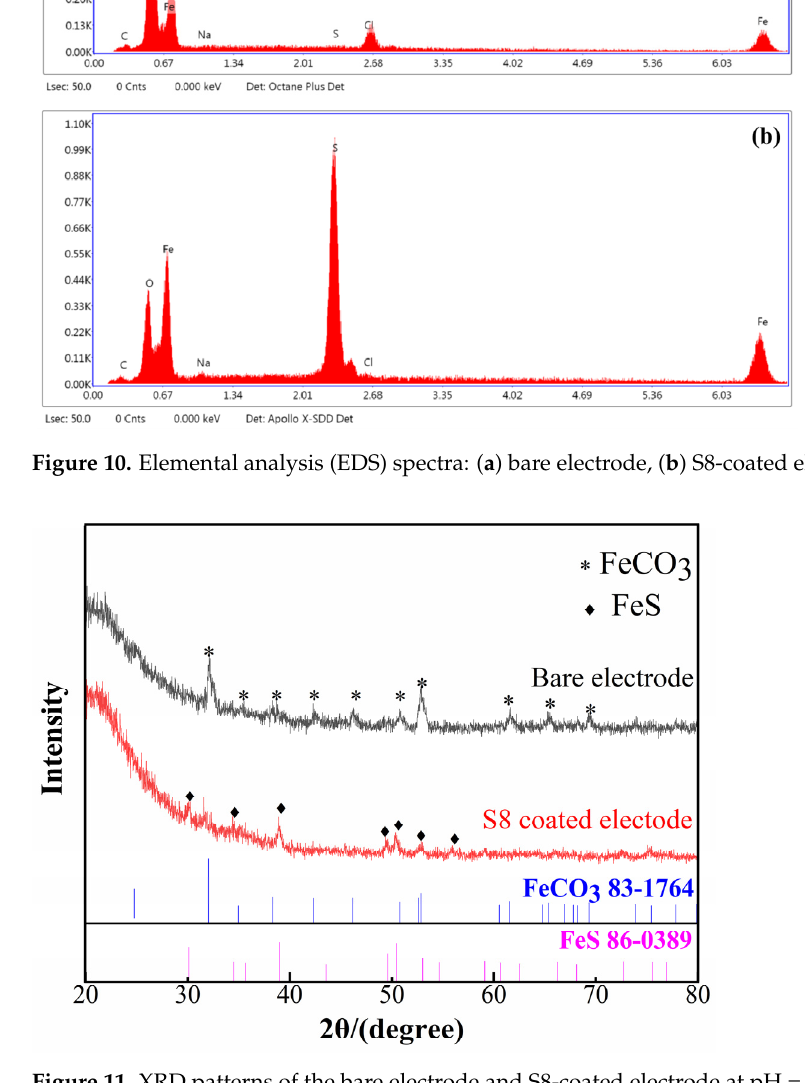
Figure 11. XRD patterns of the bare electrode and S8-coated electrode at pH = 3.10.